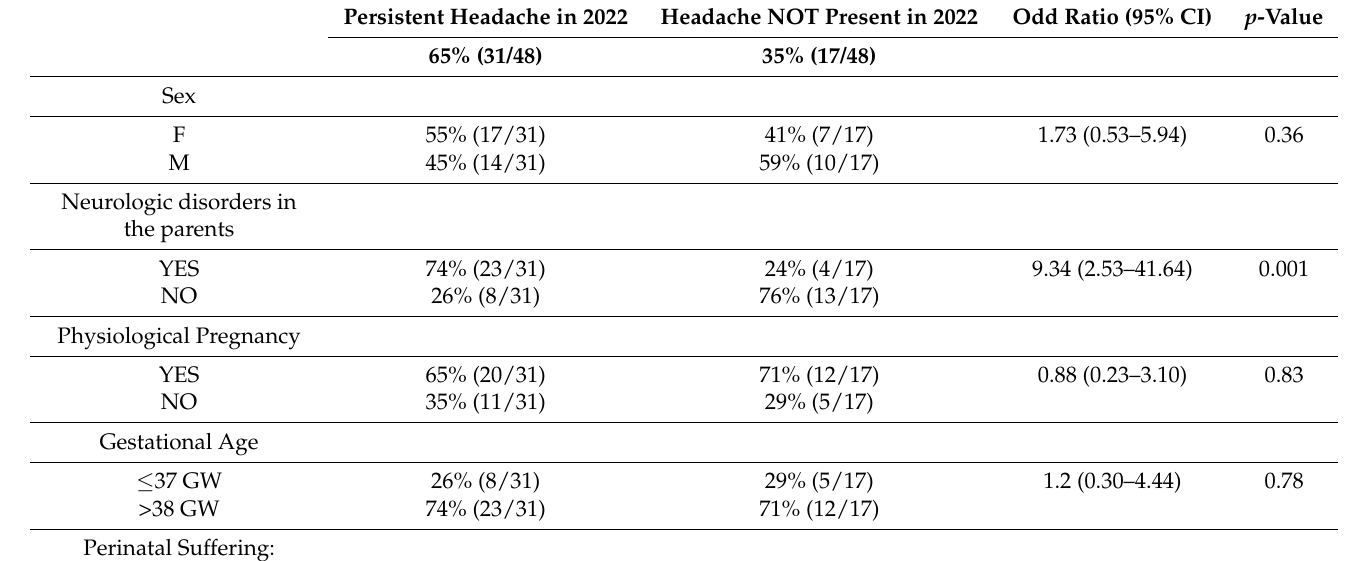
Table 3. Univariable logistic regression models of the long-term prognostic